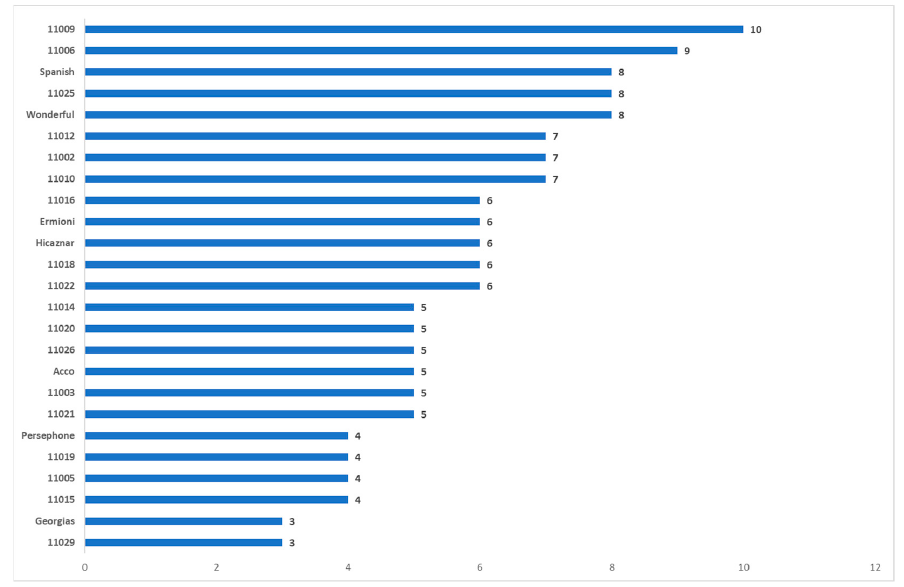
Figure 8. Number of alleles per cultivar with high and moderate negative statistically significant correlation.